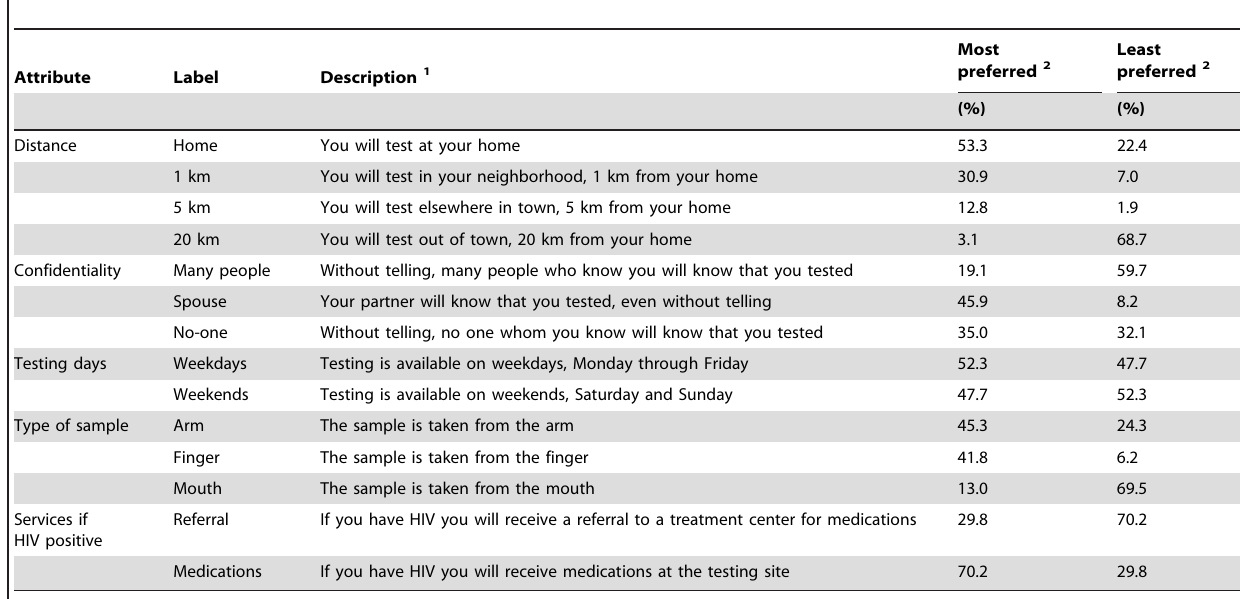
Table 1. Attributes, attribute levels, and results of the direct assessment of preferences (N= 486).